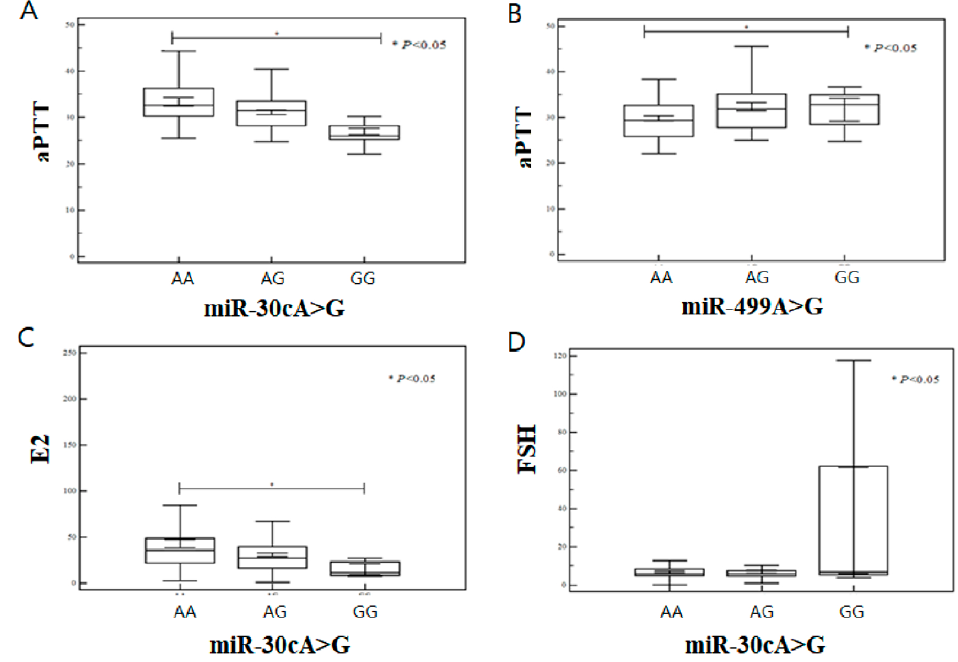
Figure 2. Analysis of variance of aPTT levels according to miRNA polymorphisms (PL ≥ 3) and analysis of variance of E2 and FSH levels according to miRNA polymorphisms. ( A ) The aPTT level was significantly different ( p = 0.001) between miR-30cA>G AA (mean ± SD, 32.46 ± 4.71), AG (31.92 ± 4.11), and GG (27.56 ± 3.59). ( B ) The aPTT level was significantly different ( p = 0.026) between miR-499 AA (mean ± SD, 31.20 ± 4.29), AG (32.62 ± 4.69), and GG (32.10 ± 4.18). ( C ) The E2 level was significantly different ( p <0.05) between miR-30cA>G AA (mean ± SD, 43.02 ± 38.58), AG (30.80 ± 19.30), and GG (15.10 ± 10.66). ( D ) The FSH level was significantly different ( p < 0.05) between miR-30A>G AA (mean ± SD, 6.96 ± 4.29), AG (6.98 ± 8.47), and GG (33.82 ± 55.85).